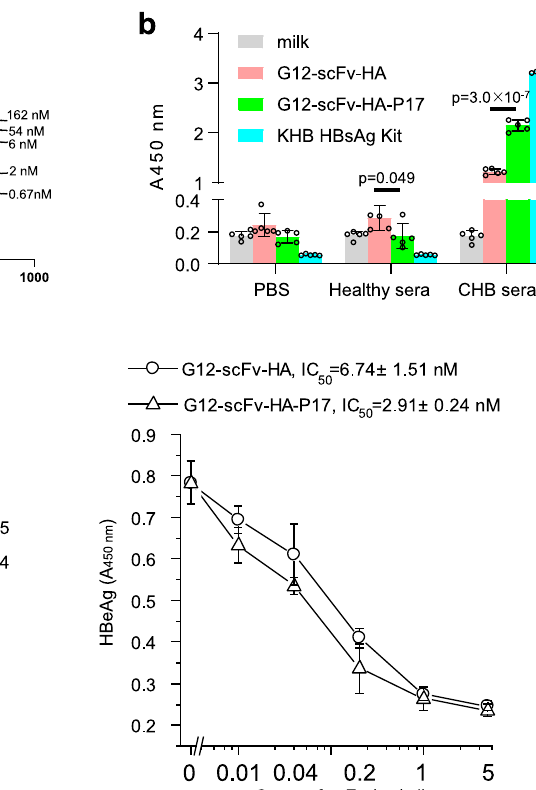
blotting and ELISA. HepG2-NTCPcells were inoculated overnight with 100 vge/cell HBV particles pre-incubated for 30min with serially diluted G12-scFv-HA or G12- scFv-HA-P17 protein. After extensive washing, cells were cultured in DMEM con- taining 2.5% DMSO. Intracellular viral RNAs (left panel) and secreted HBeAg (right panel)insupernatantsweredetectedatday5post-inoculationbynorthernblotting and ELISA, respectively. Pc RNA, precore mRNA; pgRNA, pregenomic RNA. For comparison, the signal intensity of pc/pgRNA was normalized to that of 28s and 18s rRNA (as loading controls). A 450 nm values for HBeAg subtracting the ELISA cutoff of 0.11 at various concentrations of scFvs, determined by four independent experiments, are shown. IC 50 was calculated with Origin 8.0 software. Pc/pgRNA and HBeAg from untreated cells were set at 100%. +, with HBV inoculation; − , without HBV